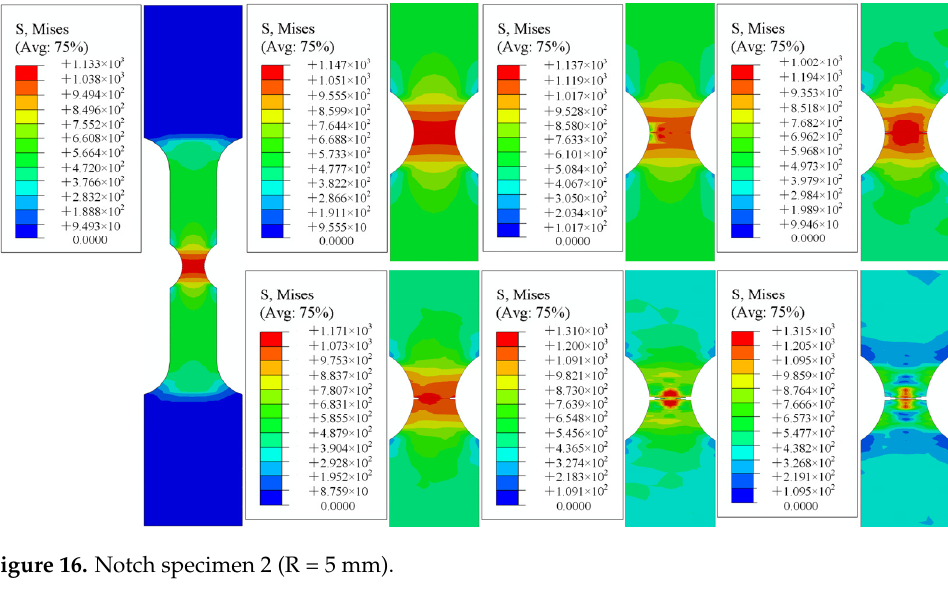
Figure 15. Notch specimen 1 (R = 2.5 mm).